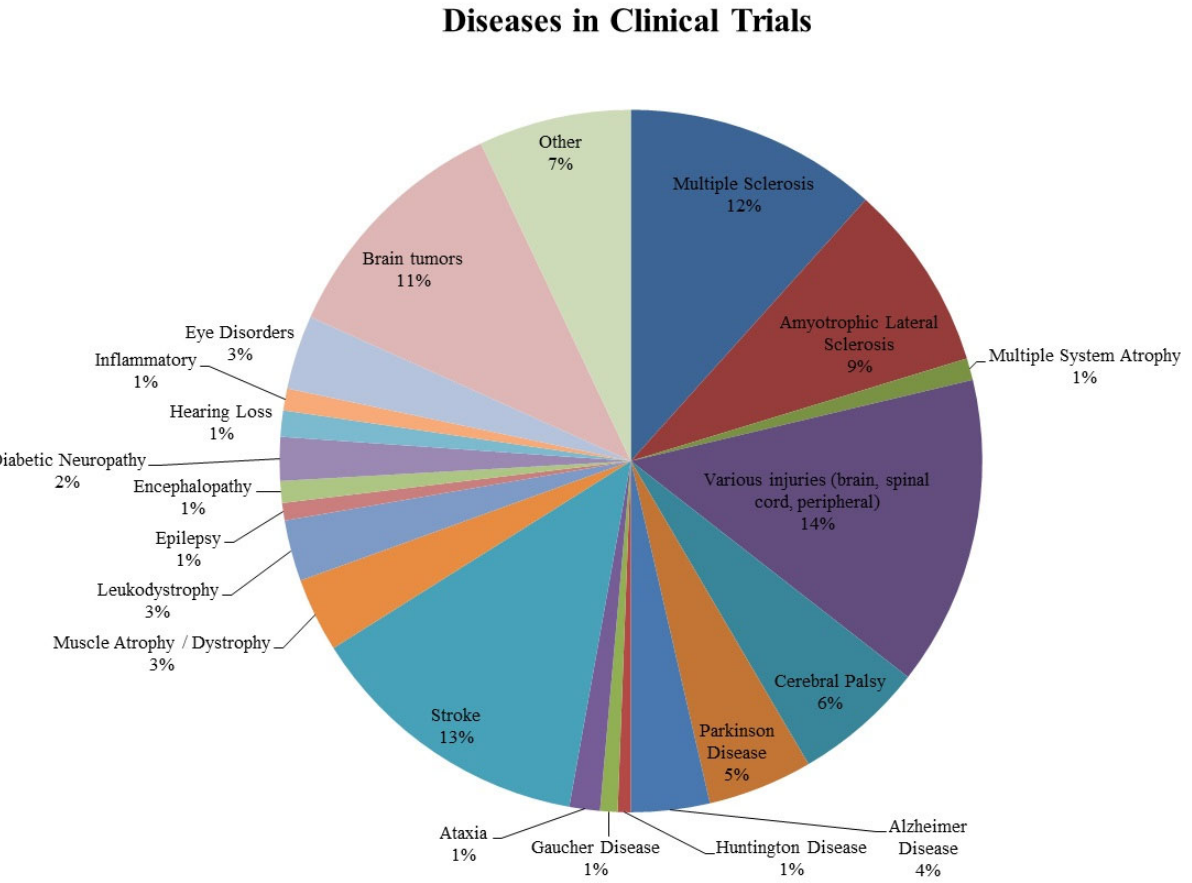
Figure 4. Conditions in clinical